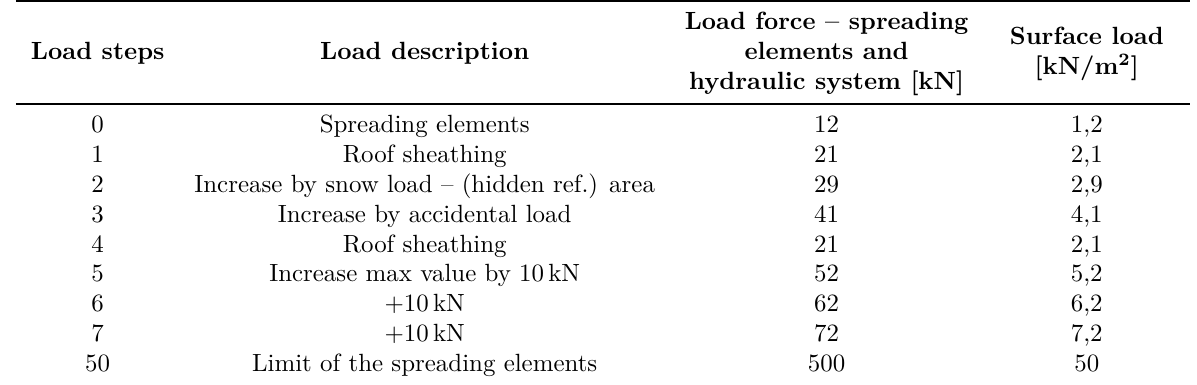
Table 1. The load